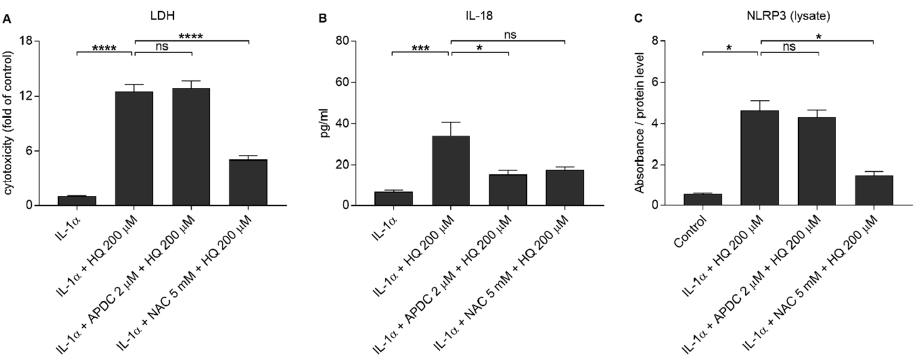
Figure 7. The effect of antioxidants (2 μ M APDC, 5 mM NAC) in conjunction with 200 μ M hydroquinone (HQ; 18 h) on the release of LDH ( A ) and IL-18 ( B ), and on the intracellular NLRP3 (C) levels in IL-1 α -primed ARPE-19 cells. Data were combined from four ( A , B ) or 2 ( C ) independent experiments containing four ( A , B ) or two ( C ) parallel samples per group. IL-18 concentrations in ( B ) were 0.745–10.597 pg/mL in the IL-1 α , 6.515–83.423 pg/mL in the IL-1 α + HQ 200 μ M, 2.58– 26.253 pg/mL in the IL-1 α + APDC + HQ 200 μ M, and 7.721–26.506 pg/mL in the IL-1 α + NAC + HQ 200 μ M group. Absorbance values in ( C ) were 0.62–0.72 in the control, 2.171–2.824 in the IL-1 α + HQ 200 μ M, 1.816–2.564 in the IL-1 α + APDC + HQ 200 μ M, and 1.266–2.25 in the IL-1 α + NAC + HQ 200 μ M group. Results are presented as mean ± SEM. * P < 0.05, *** P < 0.001, **** P < 0.0001, ns = not significant, Mann-Whitney U-test. [Kruskal-Wallis test, ( A ) *** P < 0.001, ( B ) *** P < 0.001, ( C ) *** P < 0.001].